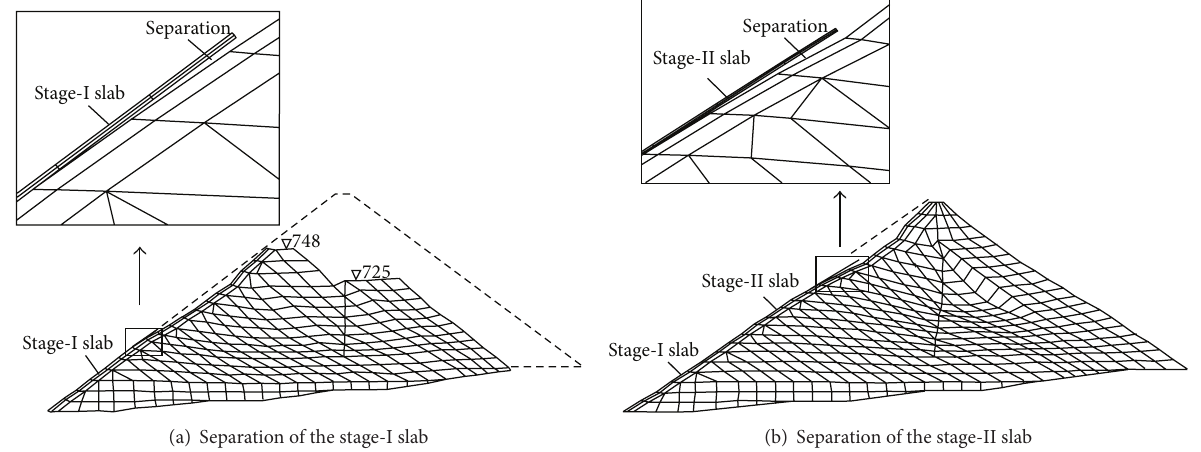
Figure 12: Separation of the slab from the cushion layer at different stages (contact analysis method).